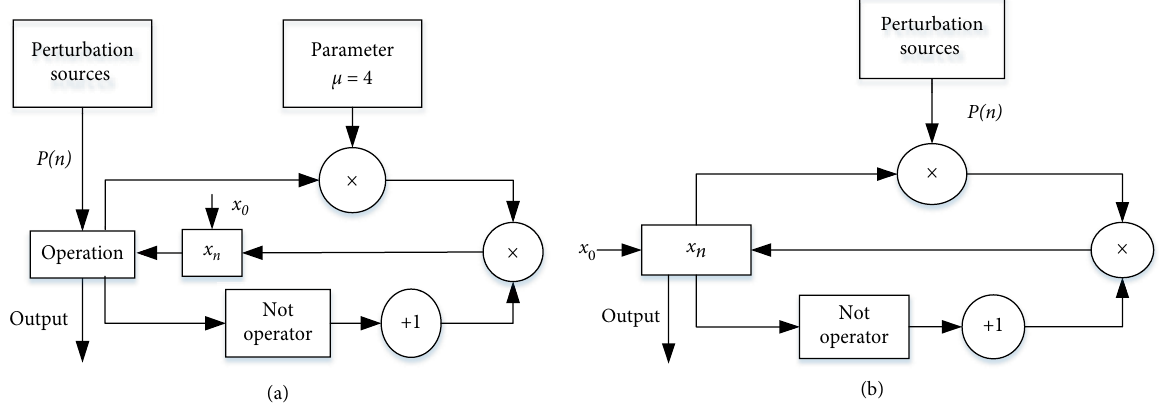
Figure 3: Diagram of perturbed digitized logistic map: (a) perturbing variable; (b) perturbing